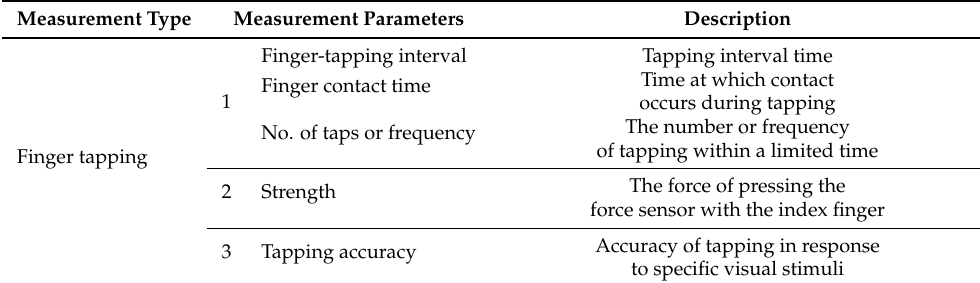
Table 3. Selected parameters to measure finger